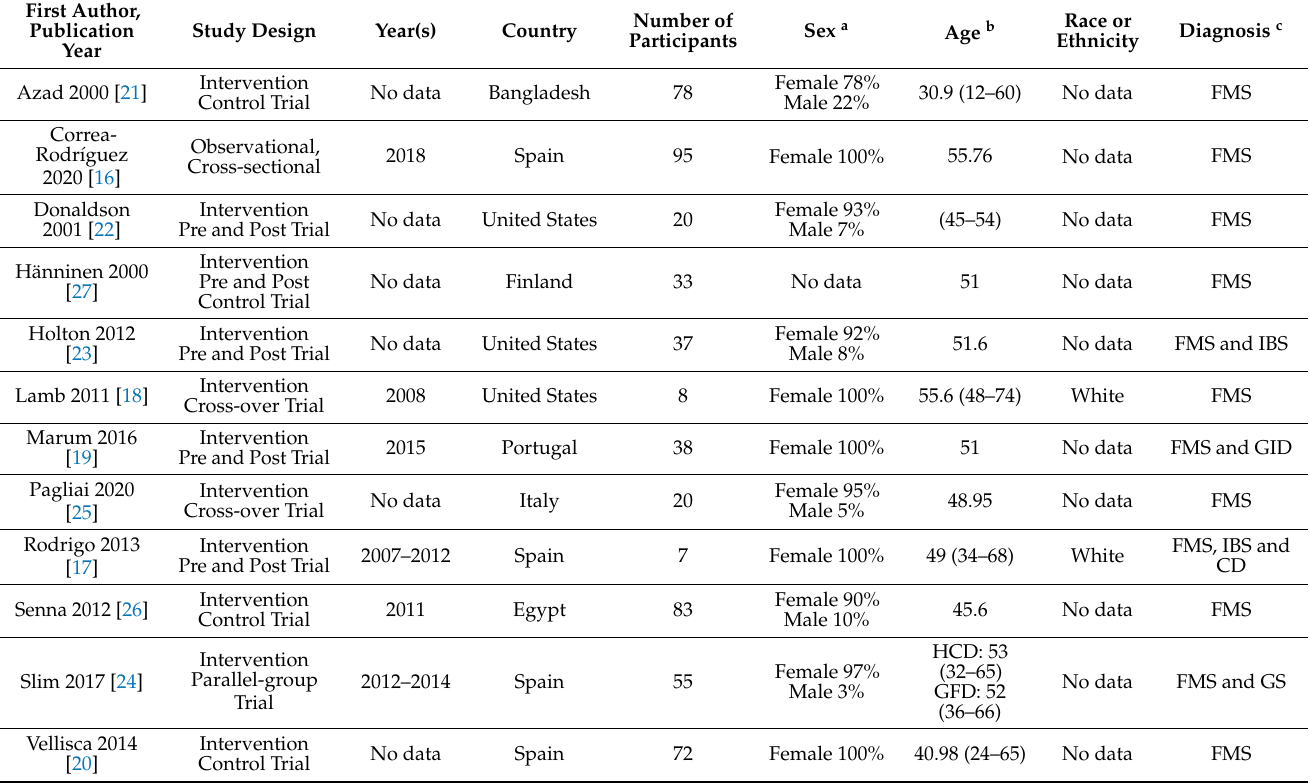
Table 1. Characteristics of studies included in the systematic